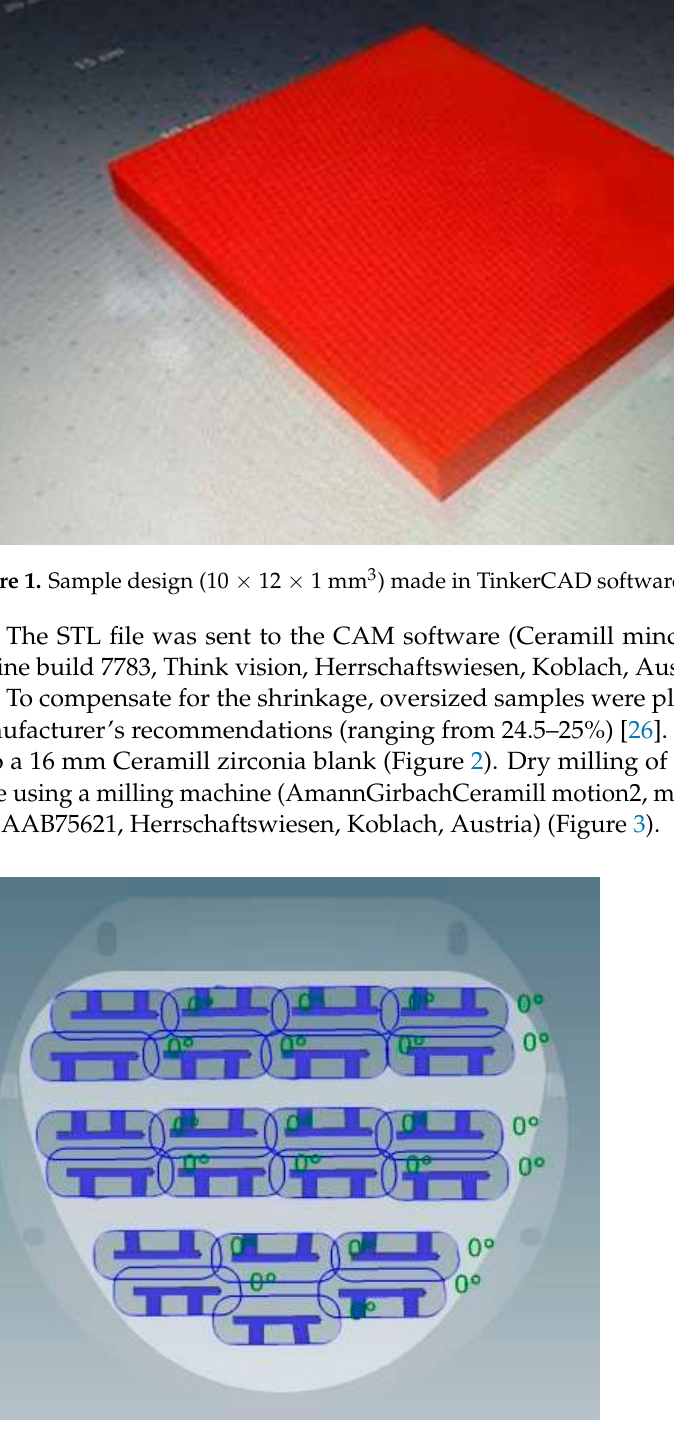
Figure 3. Dry milling of the design was done using a milling machine. Once the milling was completed, the collected zirconia samples were de-dusted. The sides having the mark of sprue attachments were polished using abrasives. The samples were then placed on the zirconia holding tray and placed inside the sintering furnace (Zir- com, KDF U.S., INC., Signal Hill, CA, USA). Four different sintering temperatures were implemented with a difference of 50 °C amongst each temperature. A total sintering cycle of 6 h and 10 min was kept constant for all the samples. The rate of rising and fall in temperature with a holding period was specific for each temperature. The procedure was repeated for other groups, respectively. Samples were cleaned ultrasonically with 80% ethanol solution (Figure 4).